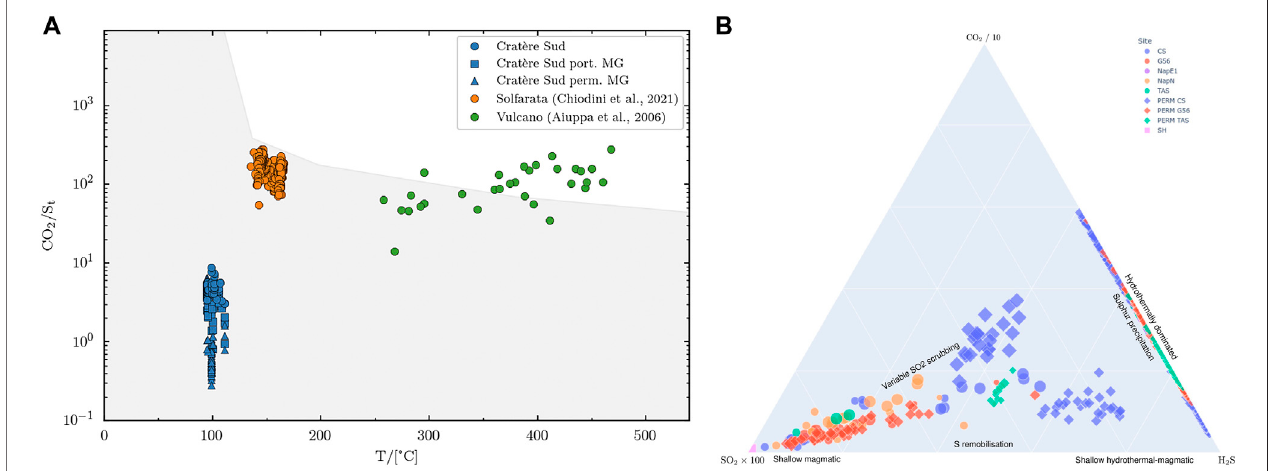
FIGURE 3 | (A) Temperature vs. CO 2 /St (St (cid:1) H 2 S) gas ratios for La Soufrière at Cratère Sud fumaroles (CS). Both MultiGas settings are shown: orange dots for portable MultiGas, green dots for permanent MultiGas, while the blue ones correspond to the Giggenbach bottle results. The grey shaded area represents the temperature dependence of CO 2 /St gas ratios in published analyses of volcanic arc gases (Aiuppa et al., 2017) while the other data correspond to Vulcano and Solfatara low-temperature fumarolic emissions obtained by Giggenbach bottles. (B) Ternary plot of CO 2 /10-H 2 S-SO 2 *100 of La Soufrière emissions measured by MultiGas (permanent and portable) representing the proposition of each species. Maximum concentrations for CO 2 , H 2 S and SO 2 for each measurement are shown. Colors are different by site, circles represent portable MultiGas, squares permanent MultiGas, and the size of the symbol indicates the period of interest (P1 and P3 having smallest and biggest symbols, respectively). The Montserrat-type magmatic end-member is shown as a square symbol.